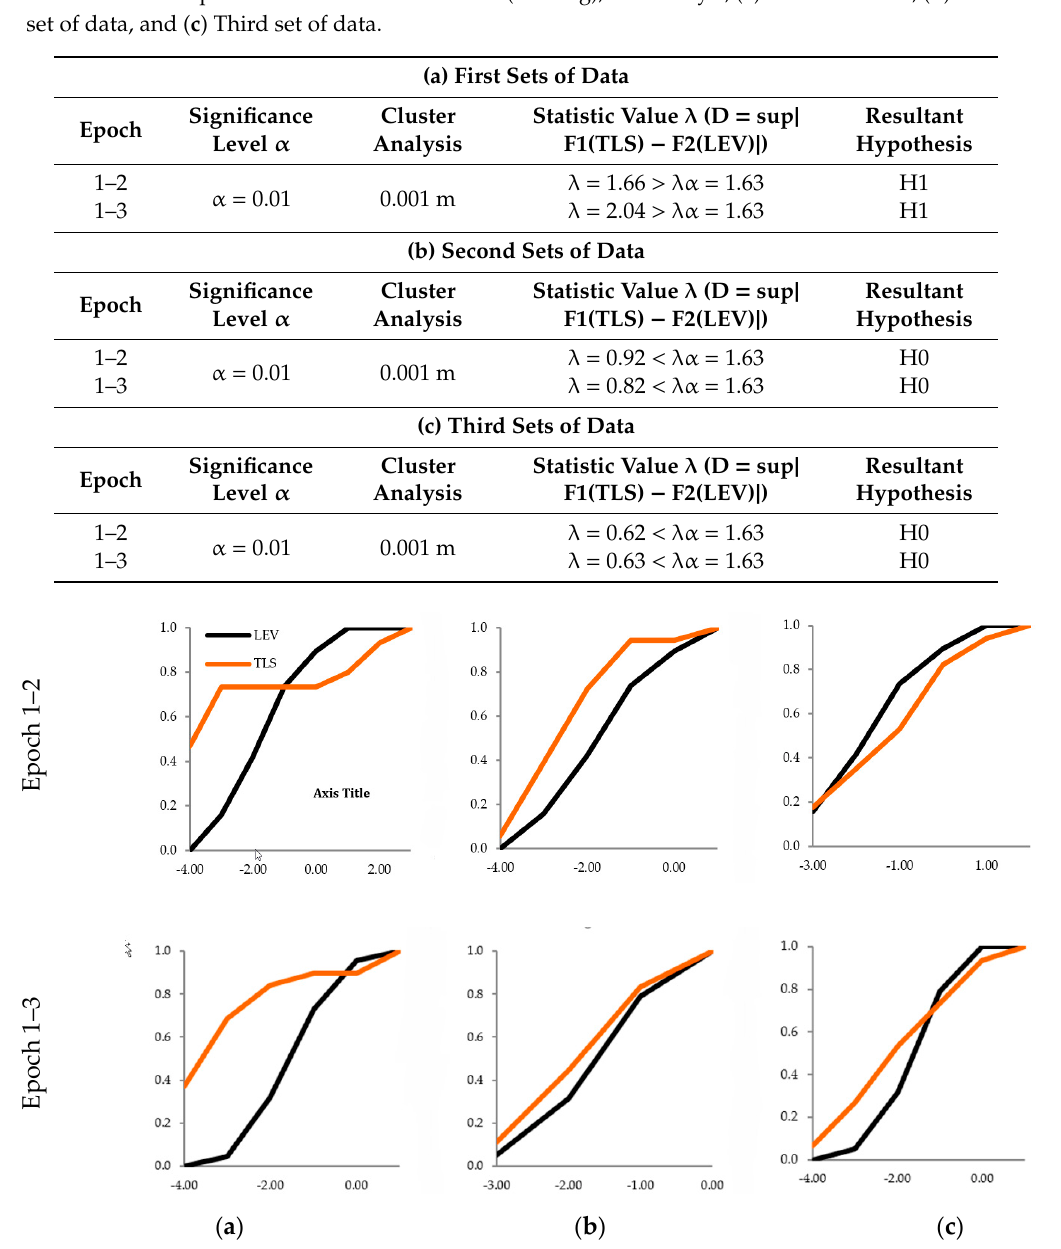
Figure 5. Distribution of vertical displacements TLS vs. LEV; OX axis: Clusters, OY axis: Distribution of displacements; ( a ) First set of data; ( b ) Second set of data; ( c ) Third set of data.